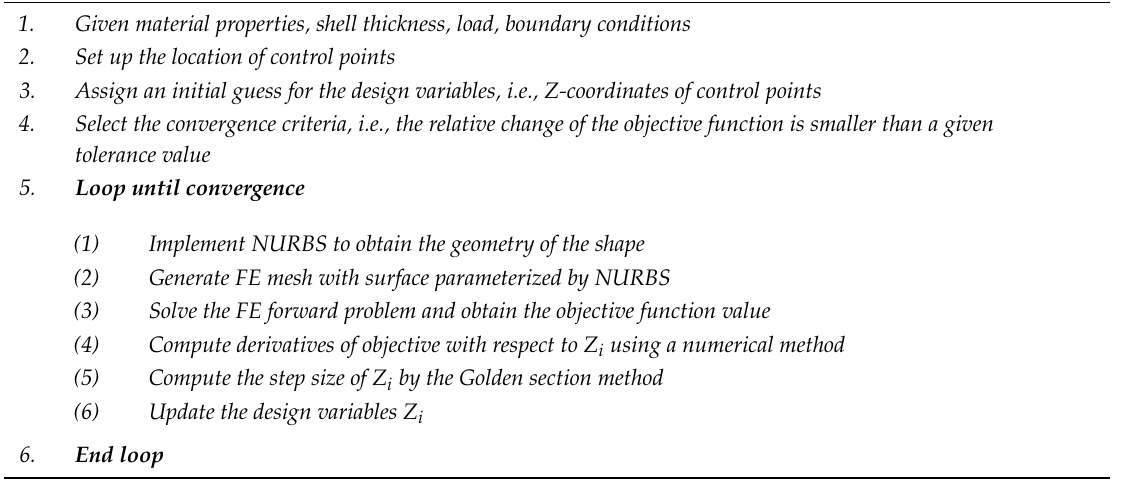
Algorithm 1 : Shape generation of free-form